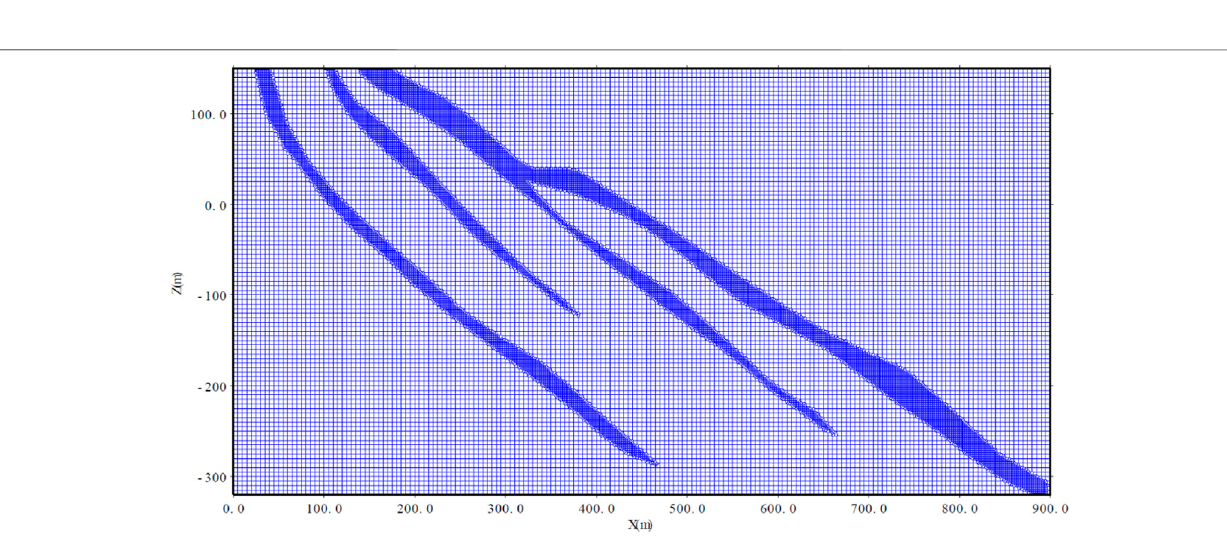
Frontiers in Earth Science |